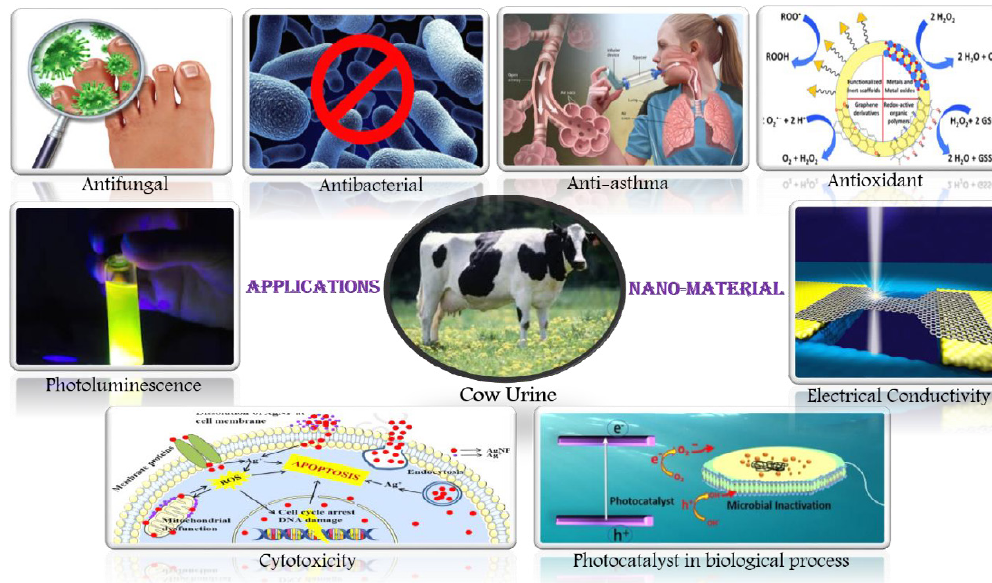
Fig. 1. Applications of NMs synthesized from cow